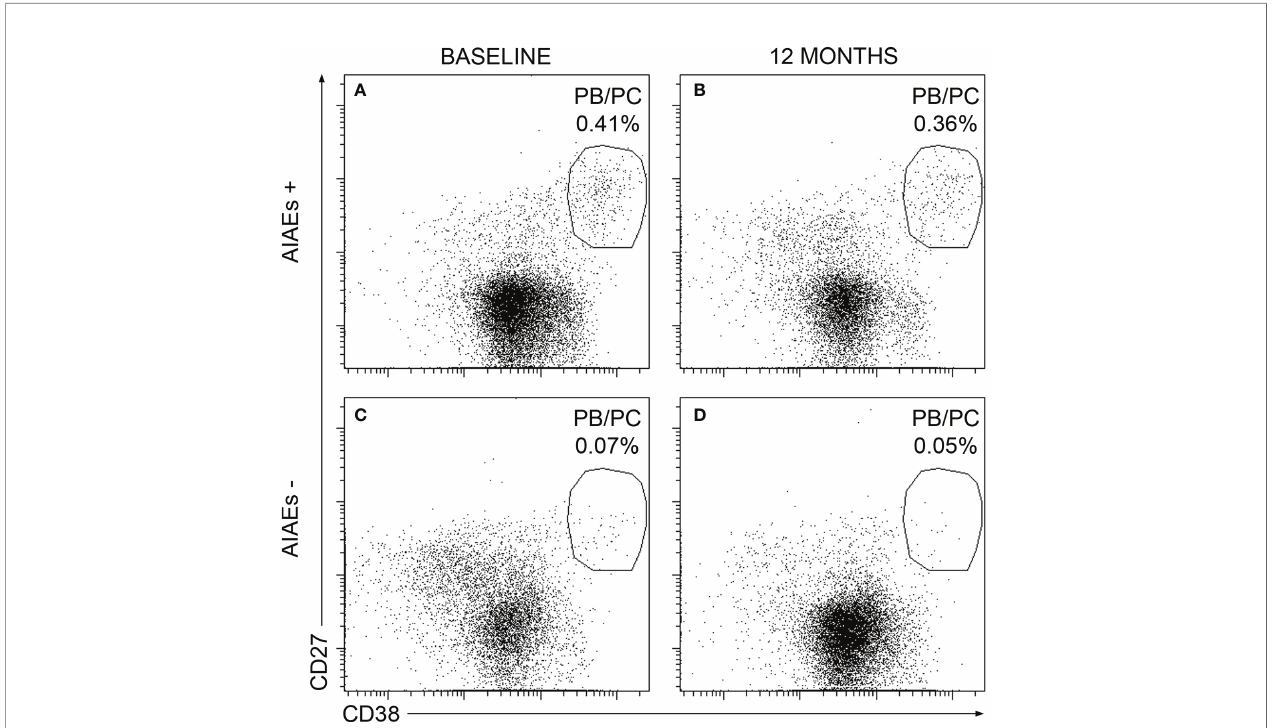
FIGURE 3 | Representative dot plots showing plasmablasts/plasma cells percentages from a AIAEs+ and AIAEs- patient at baseline and after one year of treatment. Percentages of plasmablasts / plasma cells from a AIAEs+ patient at baseline (A) and after a one year of treatment (B) and from a AIAEs- patient at baseline (C) and after one year of treatment (D) . Percentages are relative to total peripheral blood mononuclear